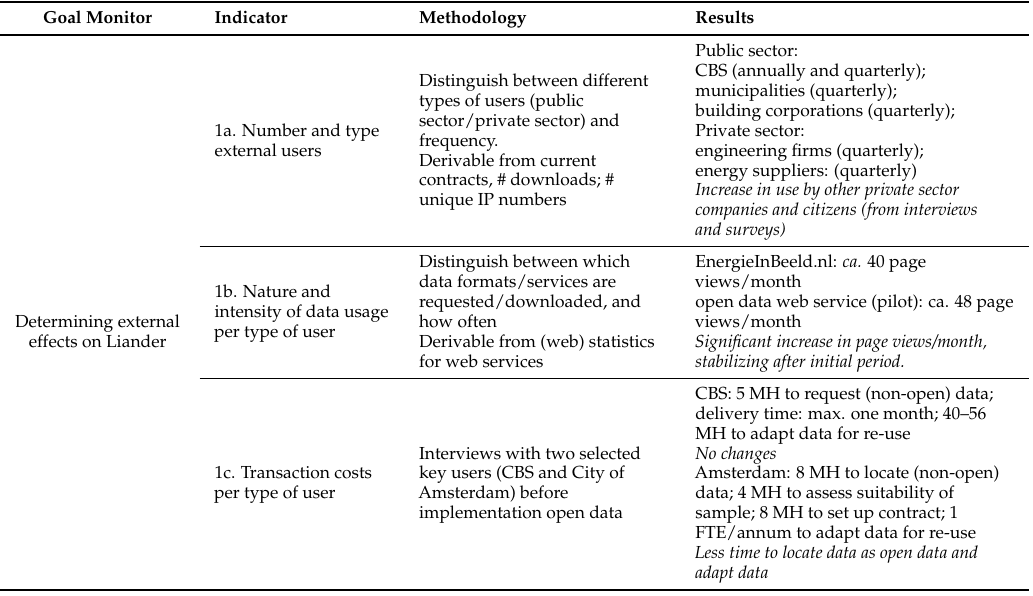
Table 2. Indicators for effect